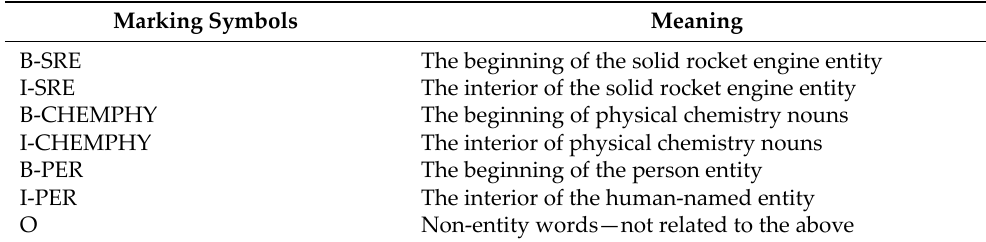
Table 1. Solid rocket engine data